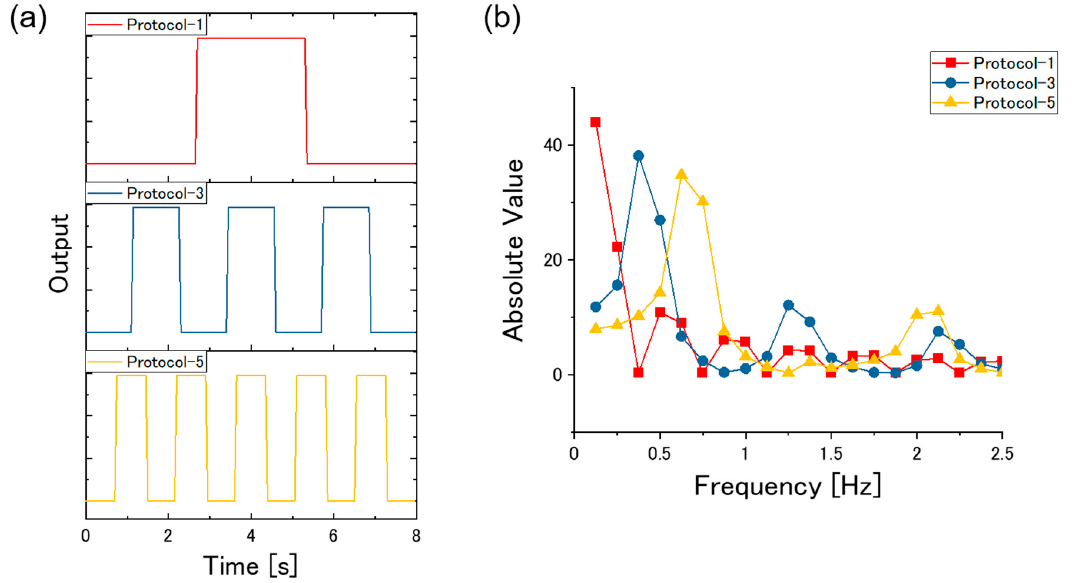
Figure 10. ( a ) Simulated waveform. ( b ) Absolute value of the frequency components for the simulated waveforms. simulated